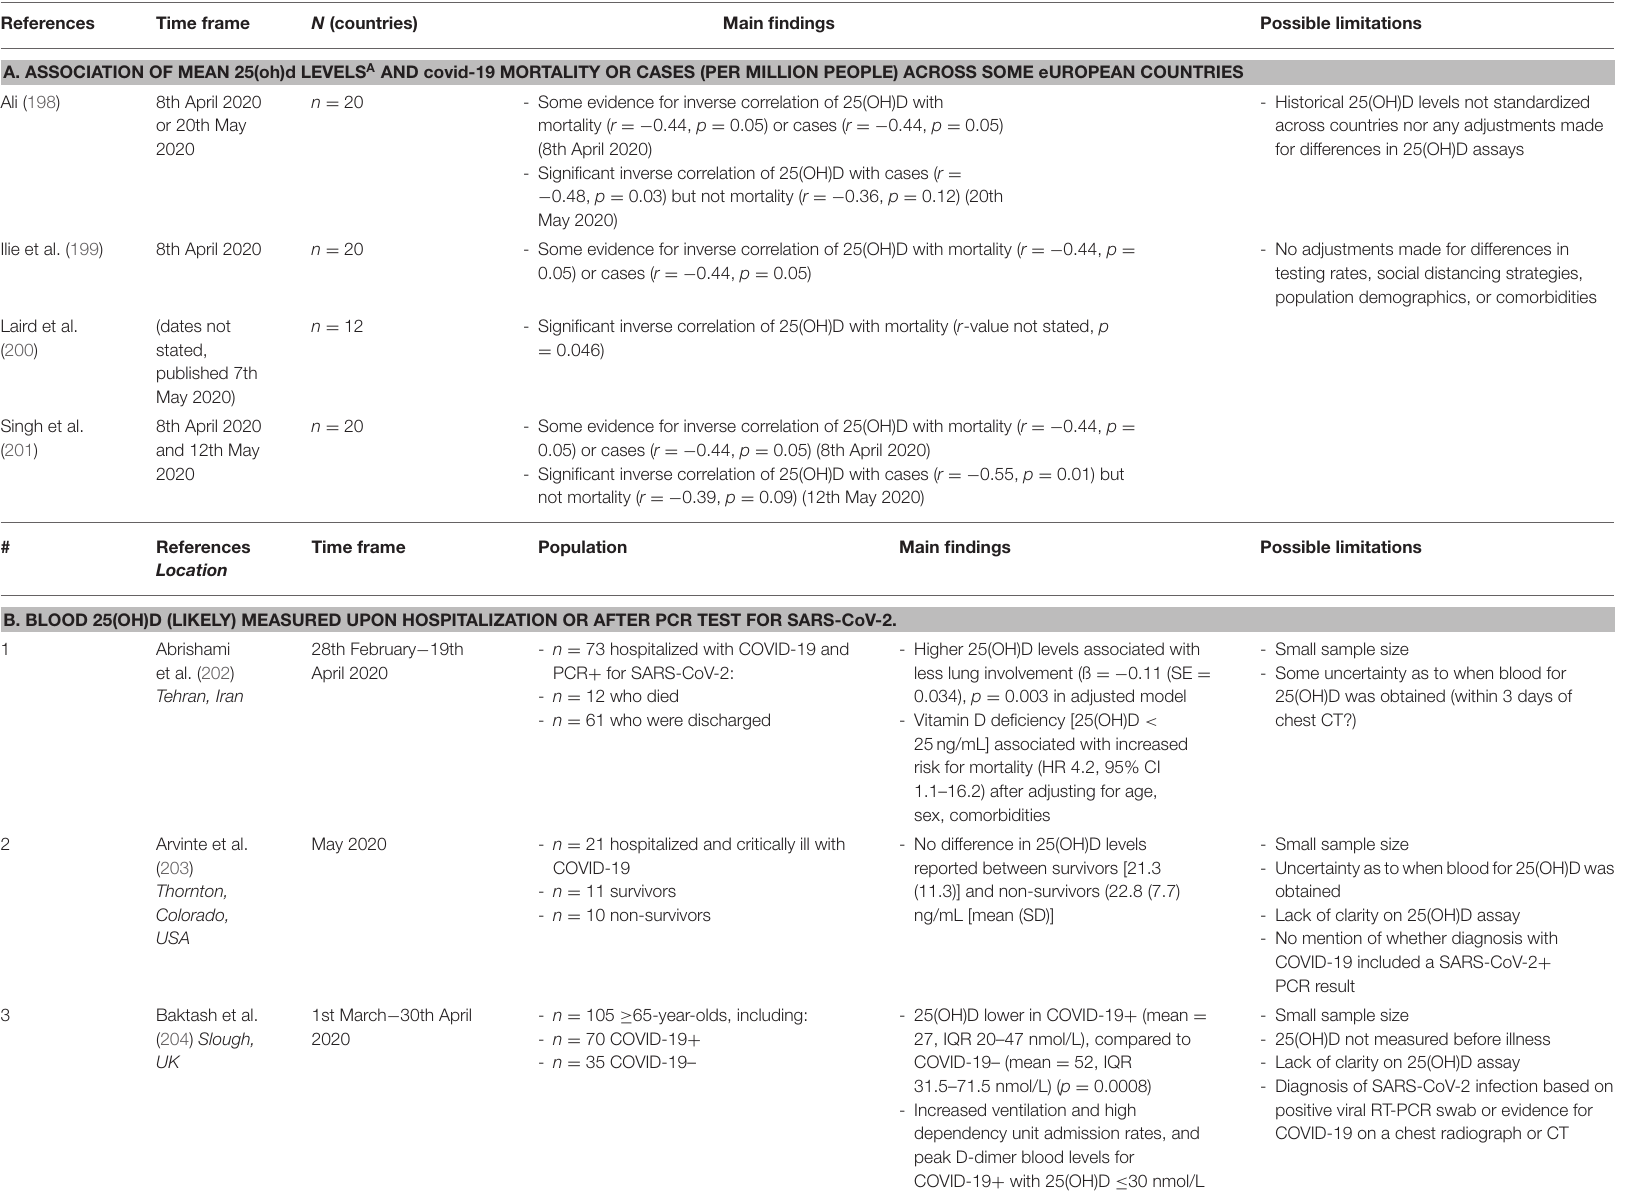
TABLE 1 | Studies reporting the associations between blood 25(OH)D level or vitamin D status and COVID-19 outcomes.